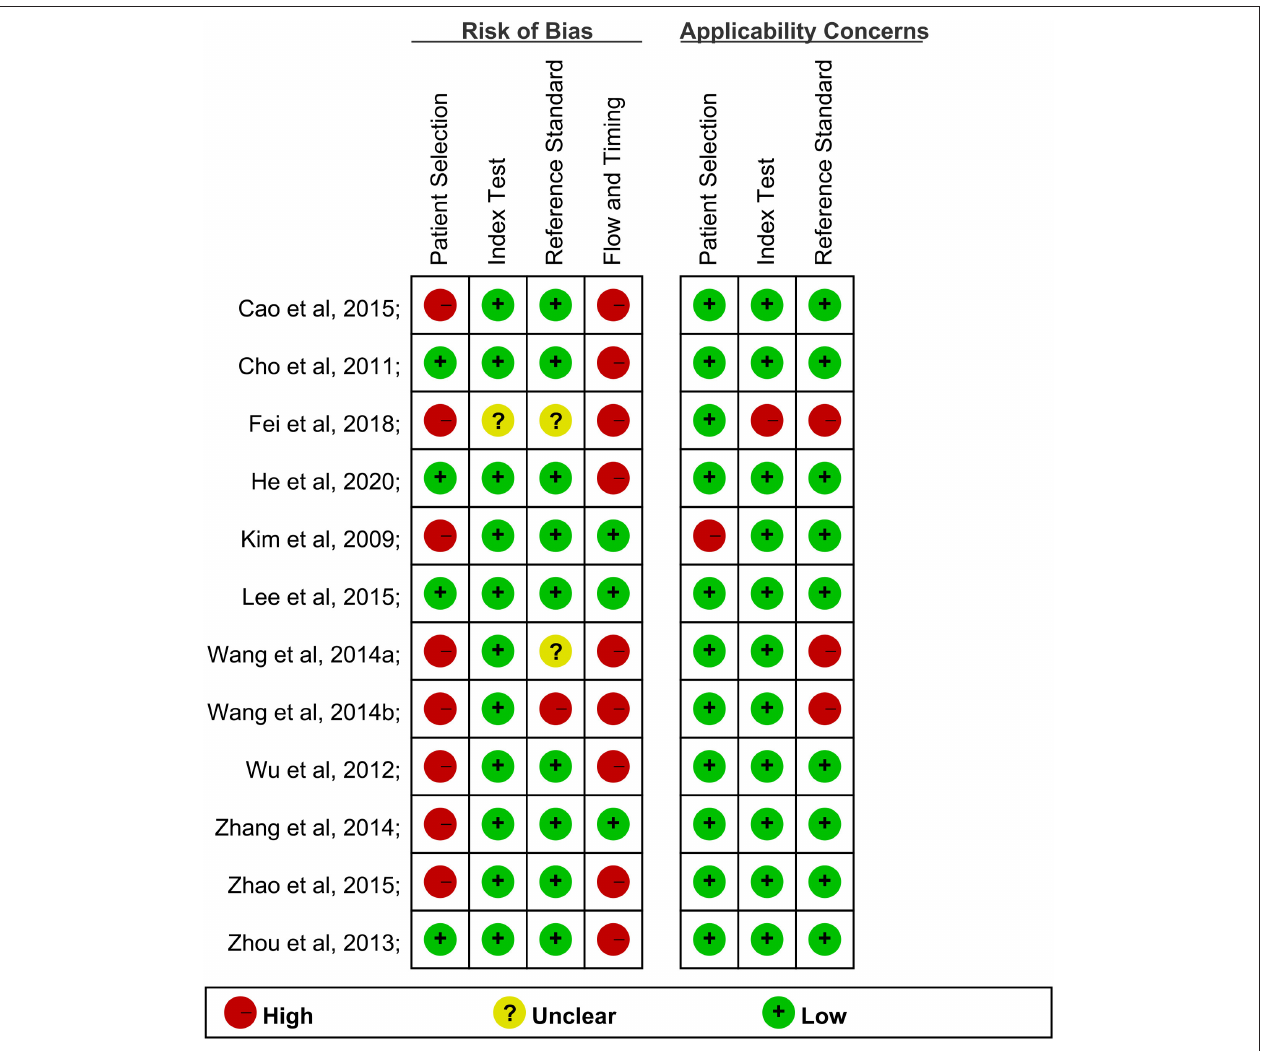
FIGURE 2 | The quality of articles